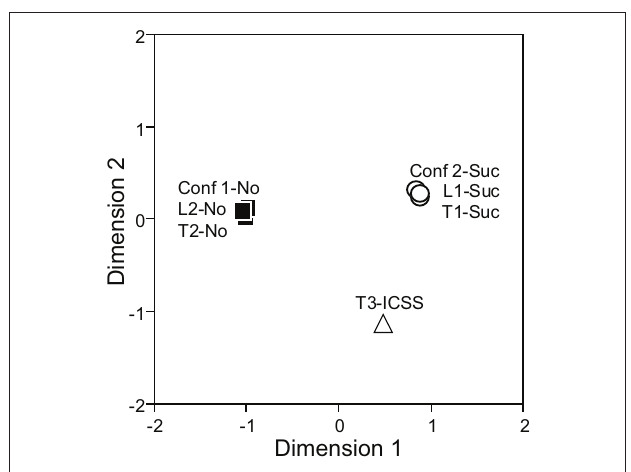
Figure 6 | Two-dimensional representation of the seven conditioned stimuli (CSs) resulting from multidimensional scaling using responses of 31 differential CS-related neurons. Note that three groups of CSs are recognized; CSs predicting the sucrose solution (Tone 1, Light 1, and Tone 2 + Light 2) indicated by white circles, the CS predicting intracranial self-stimulation (ICSS; Tone 3), indicated by a white triangle, and the CSs predicting non-reward (Tone 2, Light 2, Tone 1 + Light 1) indicated by black squares. Conf 1, Tone 1 + Light 1; Conf 2, Tone 2 + Light 2; L, Light;